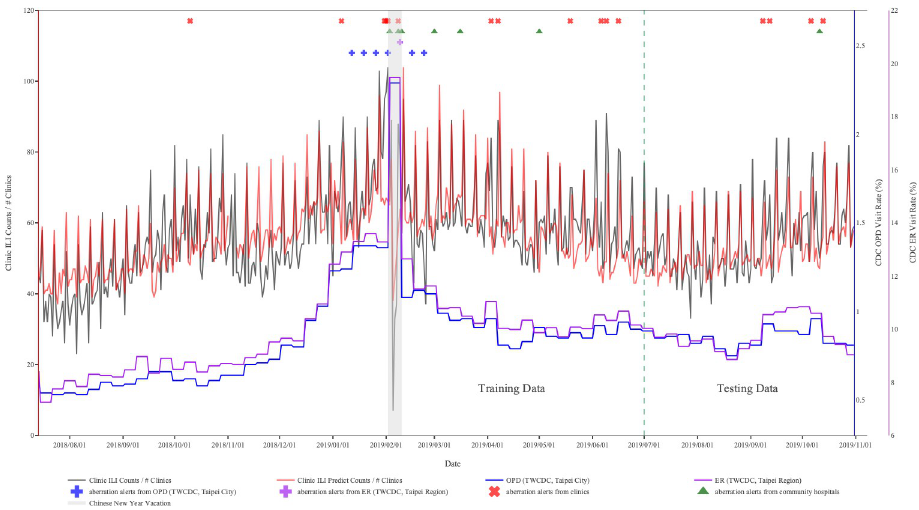
Fig 2. Results of aberration detection by proposed method using ILI syndromes collected from Sentinel plus.